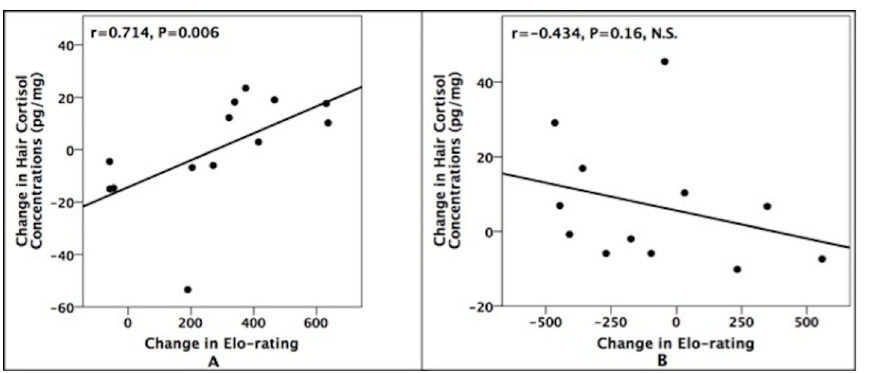
August 2014 to February 2015.